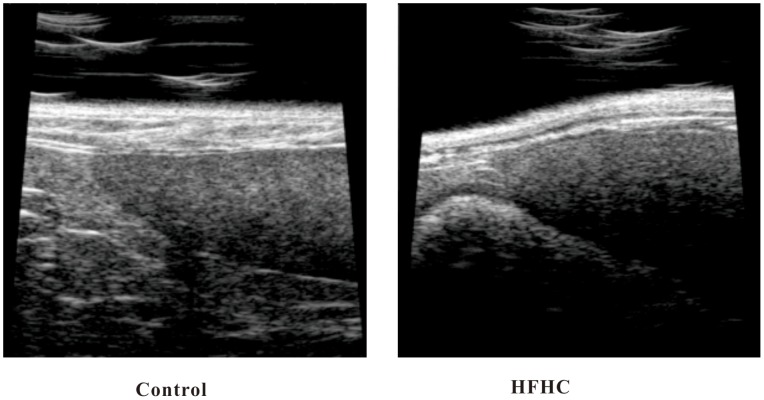
Ultrasonographic imaging of liver tissue from control (left) and HFHC hamsters (right) at week 42.